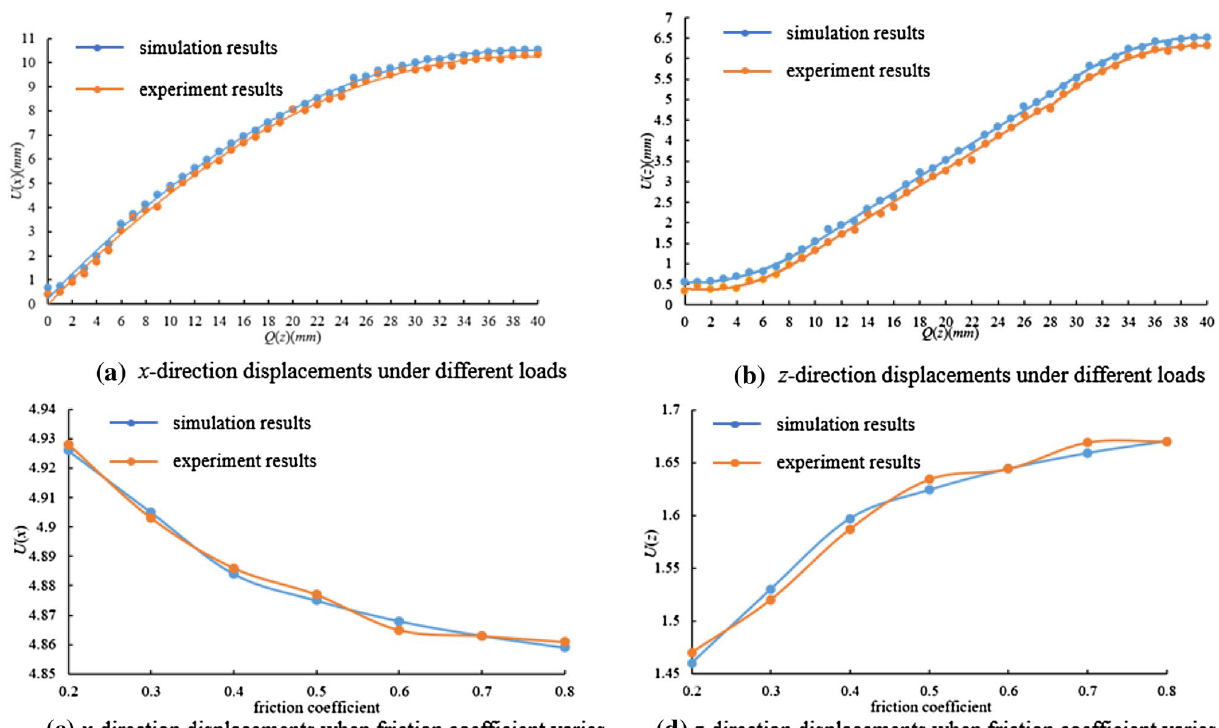
Fig. 11 Comparison of experiment results and simulation